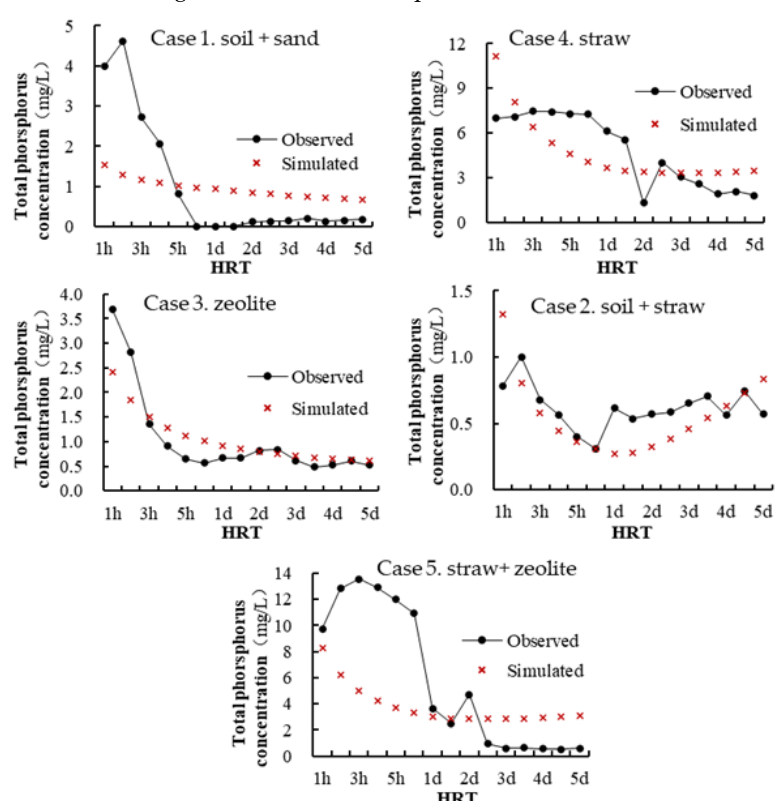
Figure 4. Comparisons of observed and simulated TP concentrations. Table 5. Statistical parameters for TP concentration simulation.